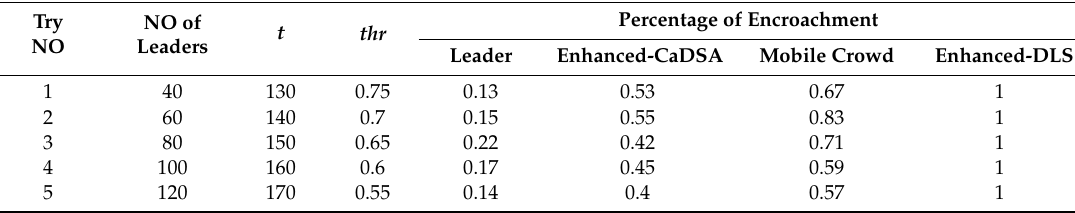
Table 2. Percentage of encroachment of the predefined